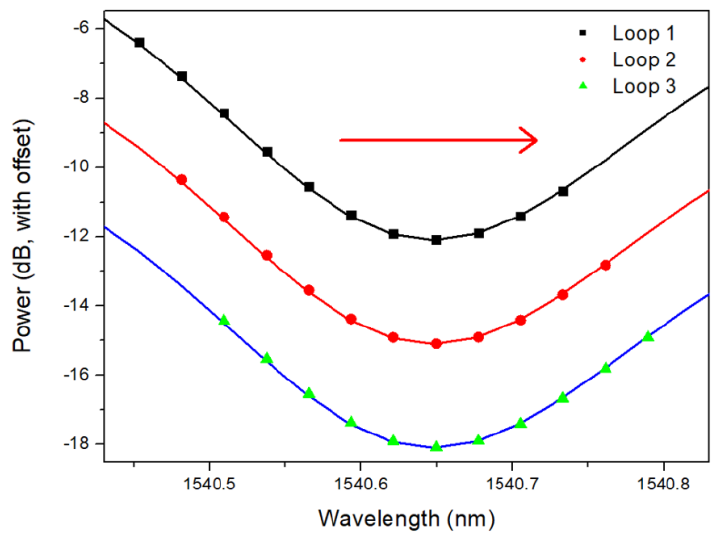
Figure 3. Schematic of SRI demodulation algorithm.